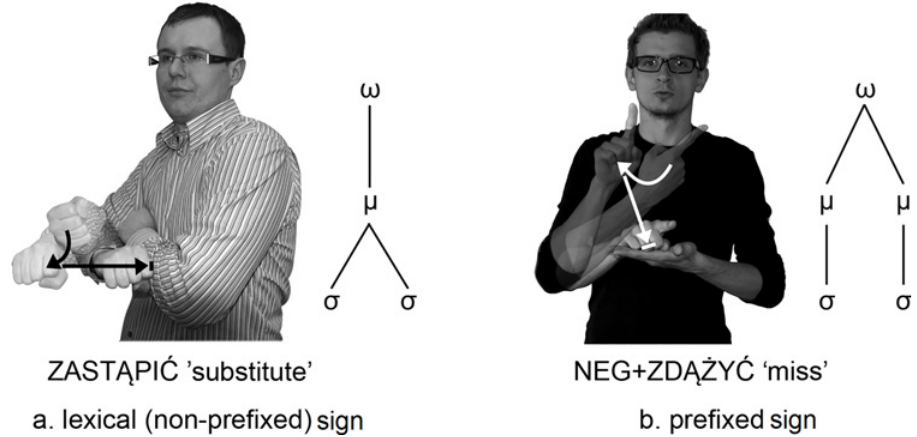
Fig 8. The comparison of two signs with identical sequences of movements: convex arc-straight. Abbreviations : ω , word; μ , morpheme; ơ , syllable. The two individuals in this figure have given written informed consent (as outlined in PLOS consent form) to publish these case